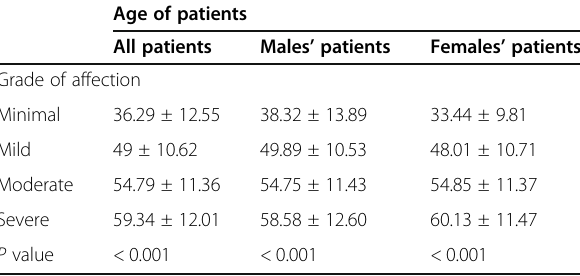
Table 5 Age of patients based on the grade of affection Age of patients All patients Males ’ patients Females ’ patients